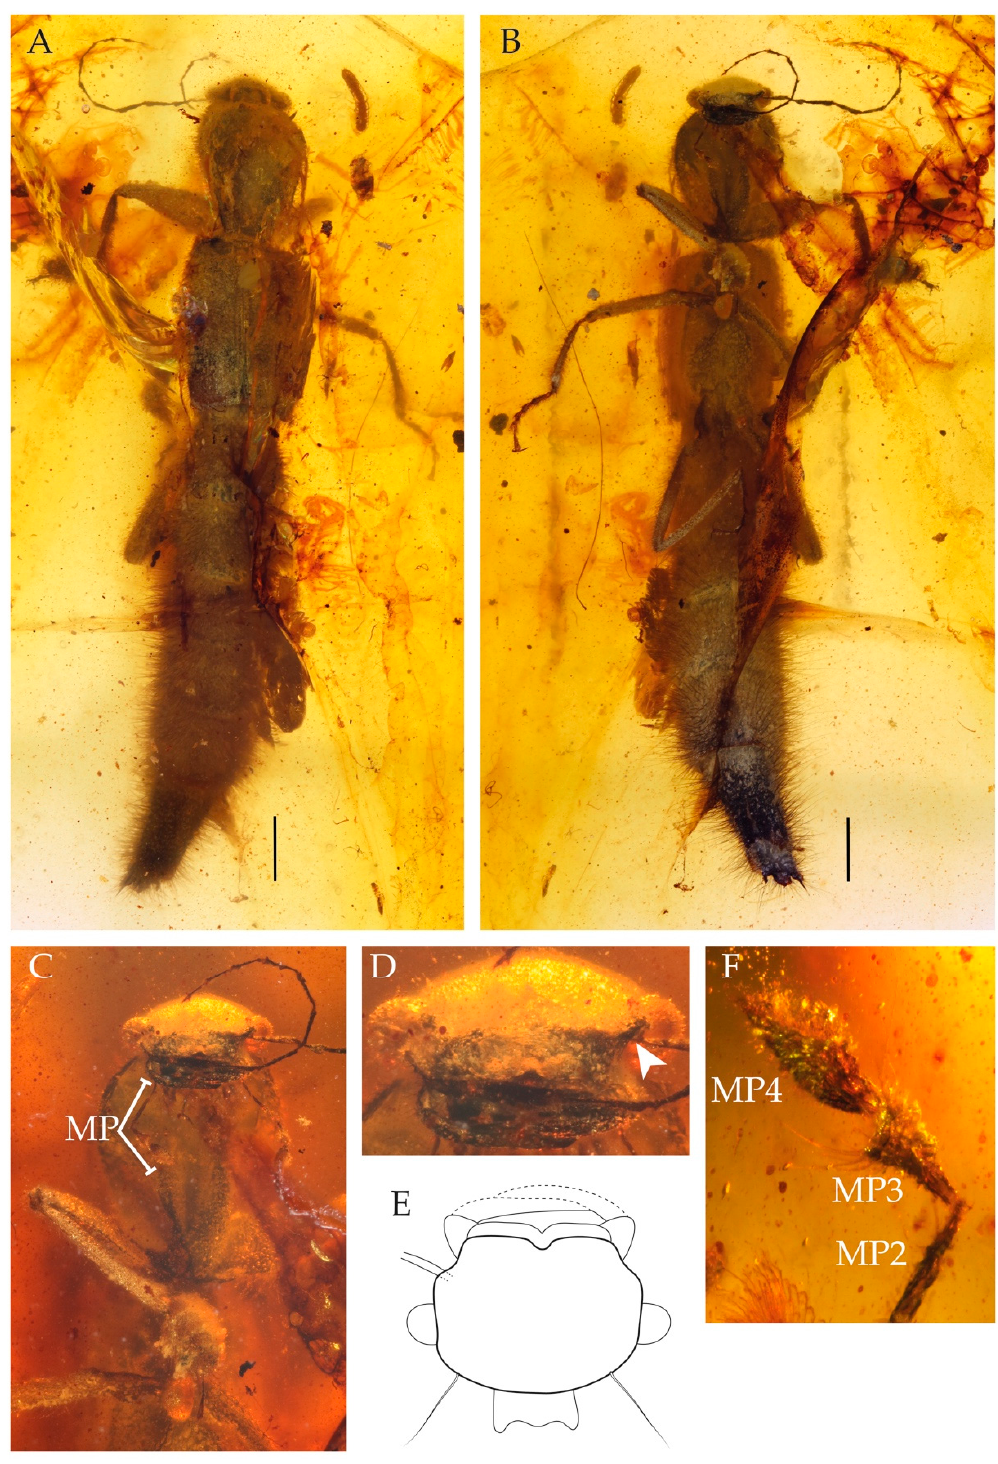
Figure 2. Morphology of Cretoprocirrus trichotos Jenkins Shaw and ˙Zyła gen. et sp. n.: ( A ) dorsal view, ( B ) ventral view, ( C ) ventral view of forebody, ( D ) frontal view of head (white arrow = “shelf” concealing antennal bases), ( E ) reconstruction of head in dorsal view, ( F ) maxillary palpomeres 2 to 4. MP = Maxillary palpomeres. Scale bars = 1.0 mm.